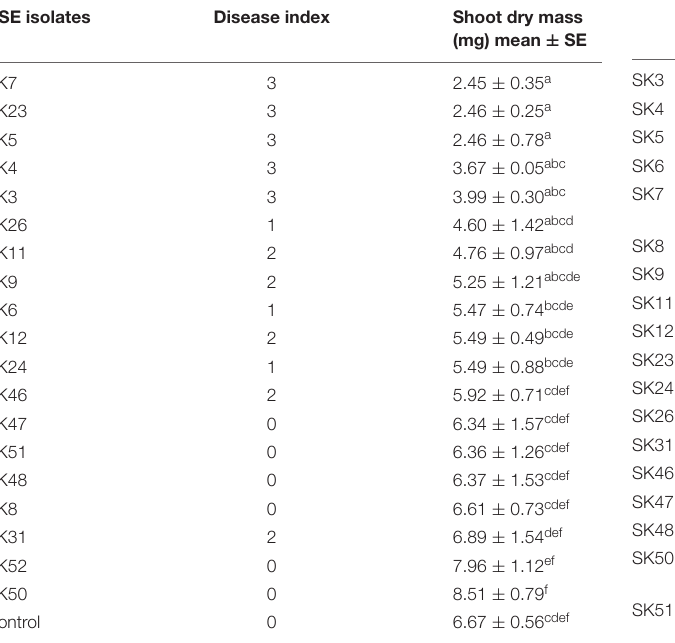
TABLE 1 | The effect of fungal isolates on the shoot dry mass and disease index of Chinese cabbage 1 . DSE isolates